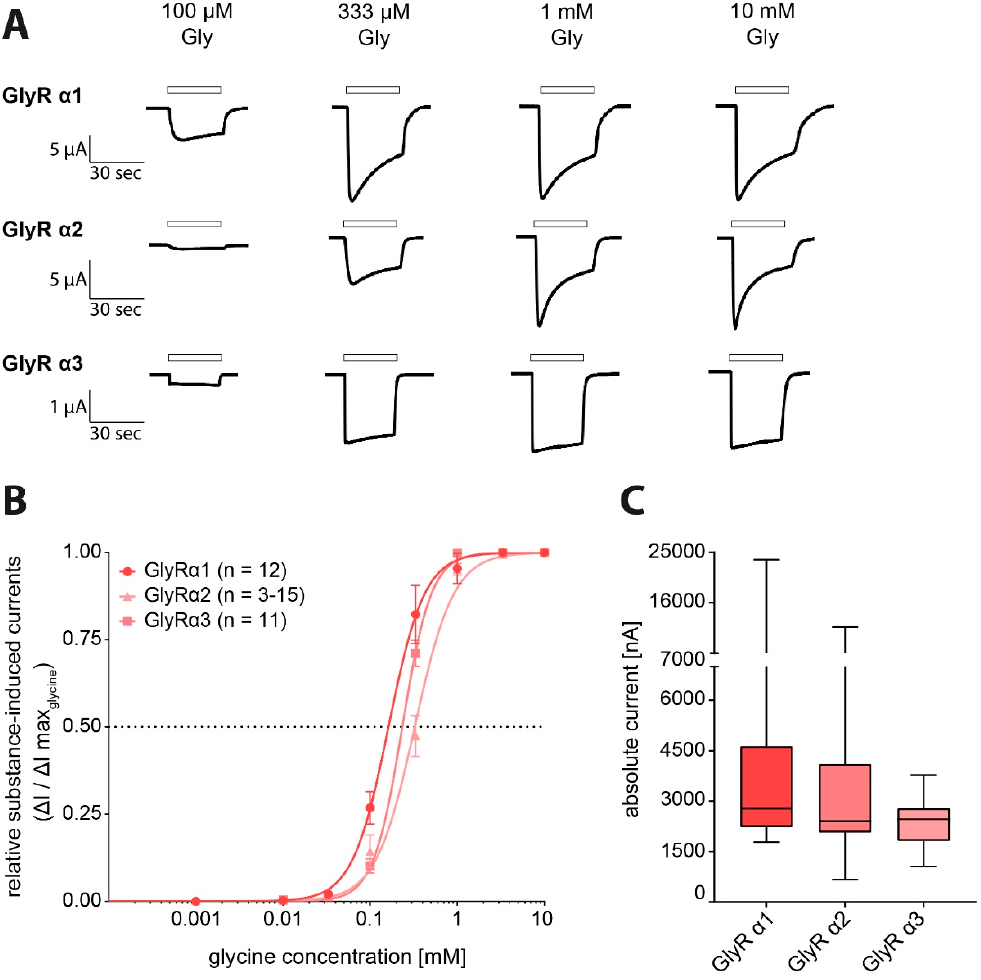
Figure 5. Functional analysis of the used glycine receptor (GlyR) constructs with glycine-induced dose-dependent current responses. ( A ) Representative extract of original electrophysiological traces in Xenopus laevis oocytes expressing GlyR subunits ( α 1-3) individually with glycine solution in increasing substance concentration (1 µ M, 10 µ M, 33 µ M, 100 µ M, 333 µ M, 1 mM, 3.3 mM, 10 mM). Substance application is indicated by black bars. Note that due to limited perfusion channel number and differing substance concentrations in each experiment, not every measurement contained all concentrations. ( B ) Dose-response curves of GlyRs showing the glycine-induced currents in relation to the maximum observed current induced by 10 mM glycine (GlyR α 1 n = 12, GlyR α 2 n = 3–15, GlyR α 3 n = 11). ( C ) Maximum glycine-induced current amplitudes [nA] determined on oocytes expressing transporter or receptor proteins individually taken together from all measurements (GlyR α 1 n = 47, GlyR α 2 n = 45, GlyR α 3 n = 40; data shown as